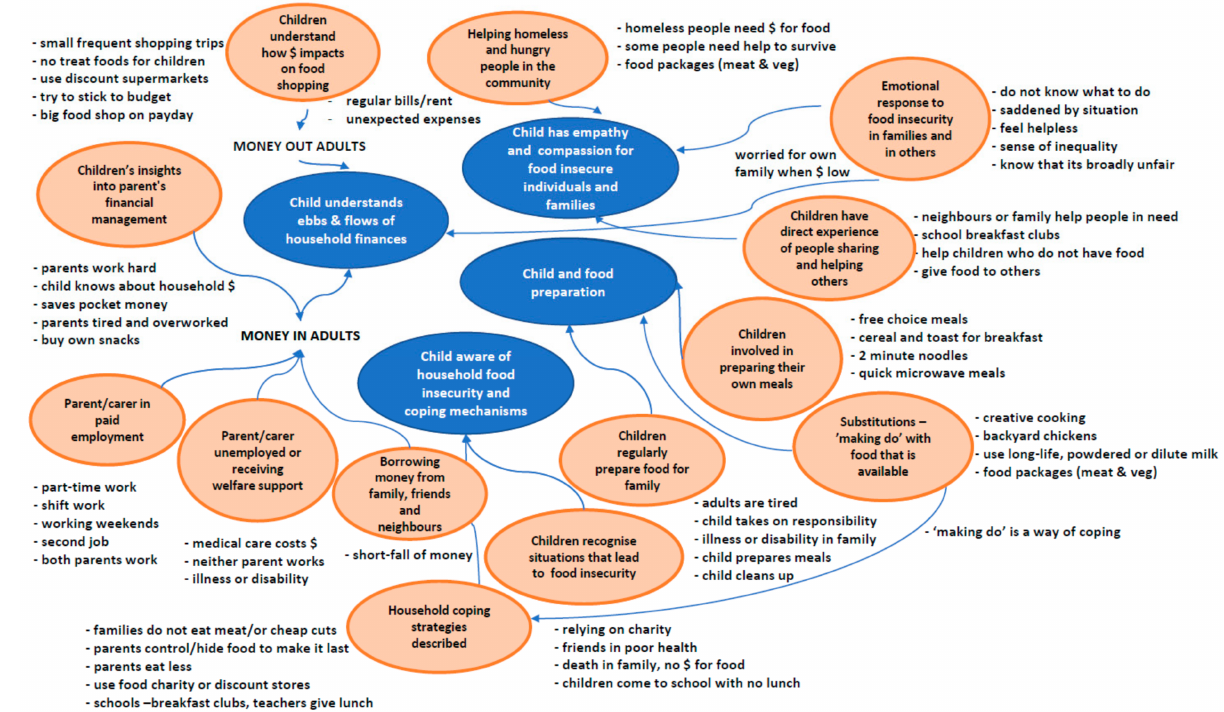
Figure 2. Thematic map of children’s perceptions, understandings, and experiences of household food insecurity. The map illustrates major themes (blue), sub-themes (orange), key ideas, and their connections